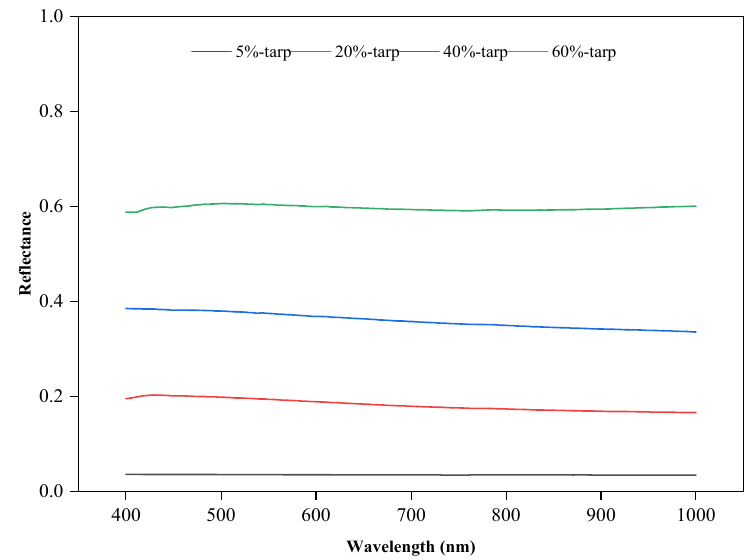
Figure 3. The laboratory measured BRF of the calibration tarps.